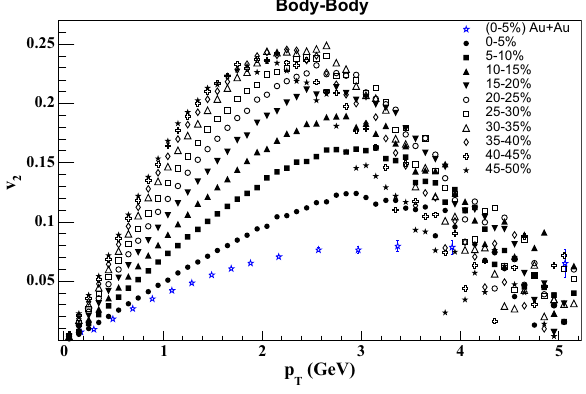
Fig. 21 Variation of elliptic flow ( v 2 ) with respect to p T in body–body configuration for various centrality classes